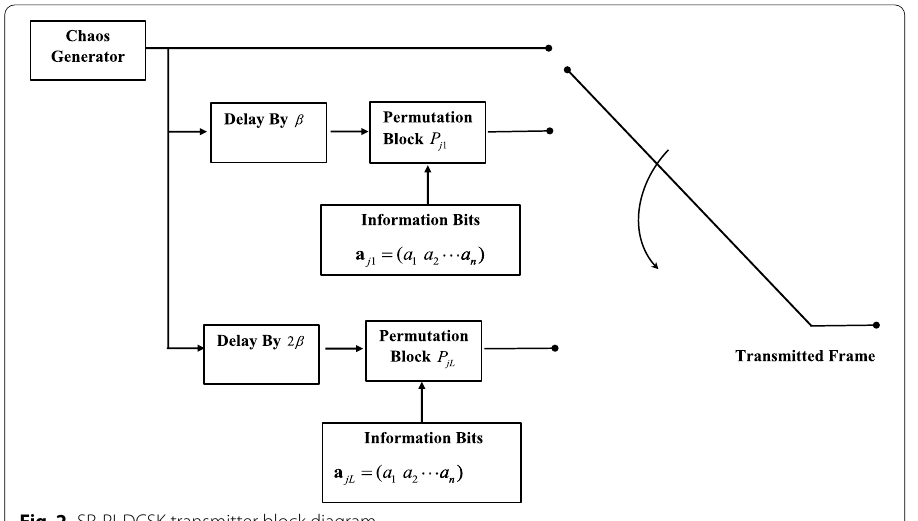
Fig. 2 SR‑PI‑DCSK transmitter block